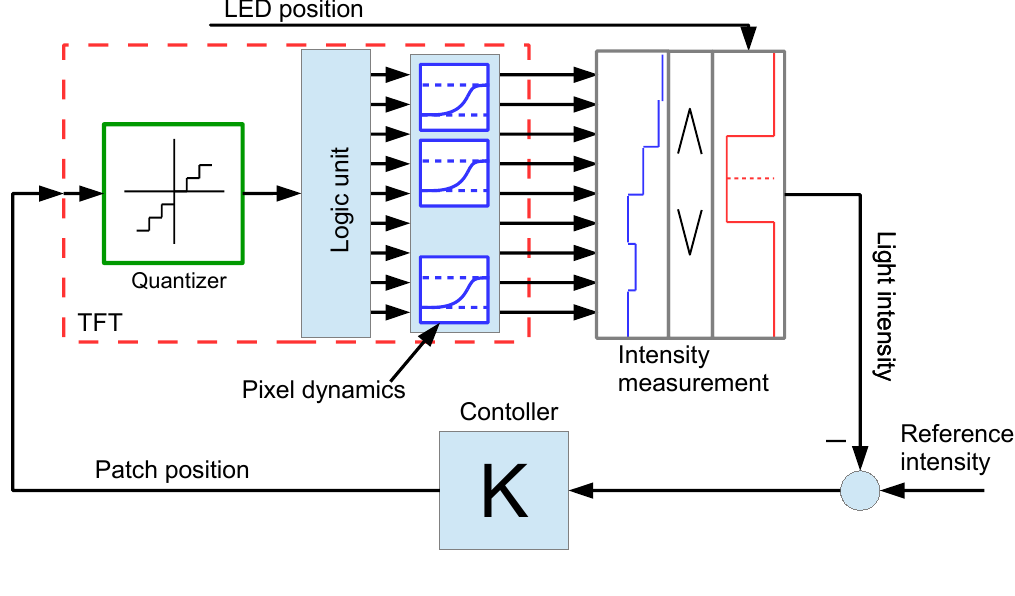
Figure 6. The LED